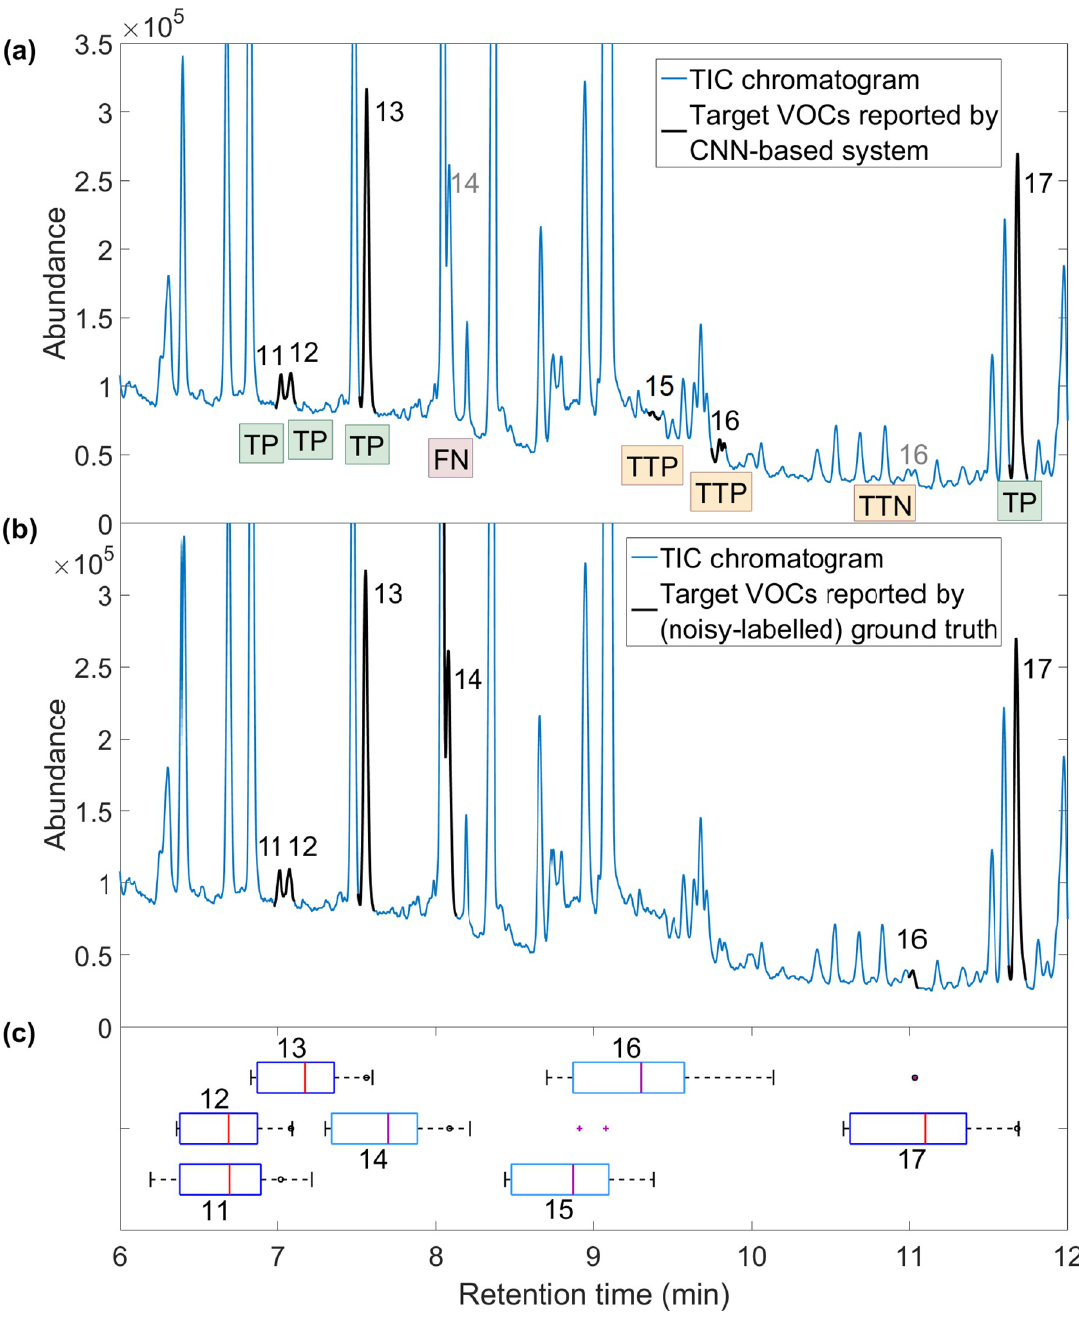
Fig 6. An evaluation of the results of a GC-MS sample scanning for VOC detection (stage 2) with the CNN-based system, range between 6 and 12 minutes; sample Test-04-BS01, model VGG-8–1D (S4.2.16 Table in S1 File). (a) VOCs detected by the system presented on total ion current (TIC) chromatogram and marked accordingly to the outcome of the evaluation. VOCs 11, 12, 13 and 17 detected alike by the system and the ground truth, true positives. VOC 14 reported by the ground truth and not detected by the system, false negative. VOC 15 not reported by the ground truth, but detected by the system in compatible RT range, tentative true positive. VOC 16 not detected by the system on the position reported by the ground truth, but detected on a different position within its RT range, tentative true negative and tentative true positive. (b) VOCs reported by the (noisy-labelled) ground truth presented on TIC chromatogram. (c) RT ranges specific for the VOCs, derived from the ground truth. Black dots indicate the exact RT positions of VOCs in the ground truth. Note that VOC 16 is reported by the ground truth at RT position being an outlier for the RT range of this compound.